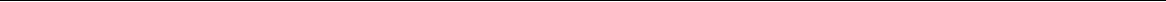
Fig. 2 JAIL formation and cell migration are blocked by Rac inhibition and VE-cadherin overexpression in scratch assay. a – f HUVECs were scratched, allowed to grow for 5 h, and labelled for VE-cadherin and Phalloidin-TRITC. a Overviews of the migrating front (left upper) and centre area (left lower). (Area 1) interrupted VE-cadherin that co-localise with fi lopodia-like actin fi laments (arrows). (Area 2) Large JAIL (arrowheads) at cell pole. (Area 3) small JAIL (arrowheads) at lateral junctions. (Area 4) Polygonal cells in the centre area. Scale bars represent 60 µ m and 15 µ m in the overview and cropped images respectively. b , c Comparison of cell perimeter and Rel-VEcad-C in front and centre ECs. Quanti fi cation of ( d ) JAIL number and ( e ) JAIL size in front ( n = 115 cells) and centre cells ( n = 186 cells). f JAIL size at cell poles and lateral junctions in front ECs ( n = 115 cells). P value was determined by unpaired student ’ s t test. g Western blot demonstrates VE-cadherin-EGFP overexpression by a factor of about 4 using VE-cadherin (green) and EGFP (red) antibodies. h VE-cadherin was immune labelled in VE-cadherin-EGFP-overexpressing and EGFP-expressing cells; nuclei were stained blue with DAPI. Scale bar: 100 µ m. i Representative images of VE-cadherin-EGFP-overexpressing and EGFP-expressing cells in a scratch assay. Red dotted lines indicate wound margins. Scale bar: 150 µ m. j Quanti fi cation of migration velocity 18.5 h after the scratch ( n = 83 and 85 cells, respectively, unpaired student ’ s t test). k , l Quanti fi cation of elongation factor and cell perimeter using CBT based on immuno fl uorescence images [ n = 176 and 205 cells for VE-cadherin-EGFP- transfected HUVECs, and n = 139 and 165 cells for EGFP-expressing HUVECs at distance ( ≈ 0 – 200) and ( ≈ 200 – 400) in the scratch area, two-way ANOVA]. m Time-lapse series of HUVECs expressing LifeAct-EGFP after scratching. (Left) Overview image (scale bar: 50 µ m) indicates the scratch front (dotted line) and the white box represents the cropped area. JAIL formation (arrowheads) in the same cells was blocked by EHT1864, while fi lopodia still developed (arrows). Time scale: hh:mm, scale bar: 10 µ m. Live-cell imaging-based analyses of ( n ) cell perimeter (front to 200 µ m, n = 50 cells) and ( o ) wound closure ( n = 3) (two-way ANOVA). Representative results from three independent experiments were shown. Error bars represent ± SEM.